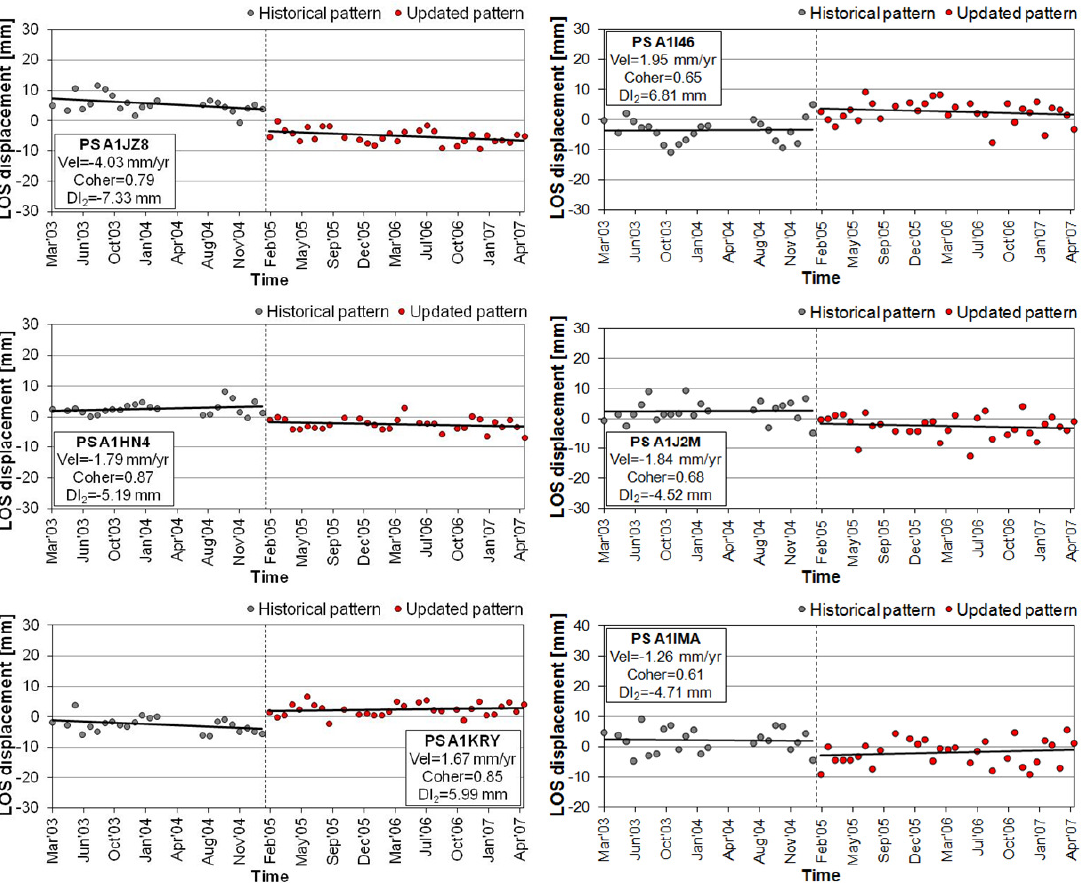
Fig. 8. Naro test site: examples of PS time series showing high values of DI 2 . PS locations are shown in Fig. 7. The coefficients of determination R 2 for the H and U intervals of the time series are respectively: 0.160 and 0.159 (PS A1JZ8); 0.001 and 0.024 (PS A1I46); 0.049 and 0.039 (PS A1HN4); 0.002 and 0.017 (PS A1J2M); 0.134 and 0.021 (PS A1KRY); 0.002 and 0.020 (PS A1IMA).